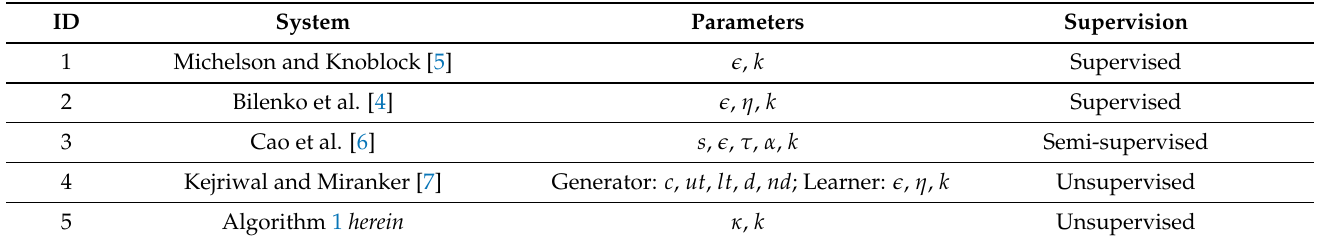
Table 1. Disjunctive Normal Form Blocking Scheme Learner (DNF-BSL) Systems.